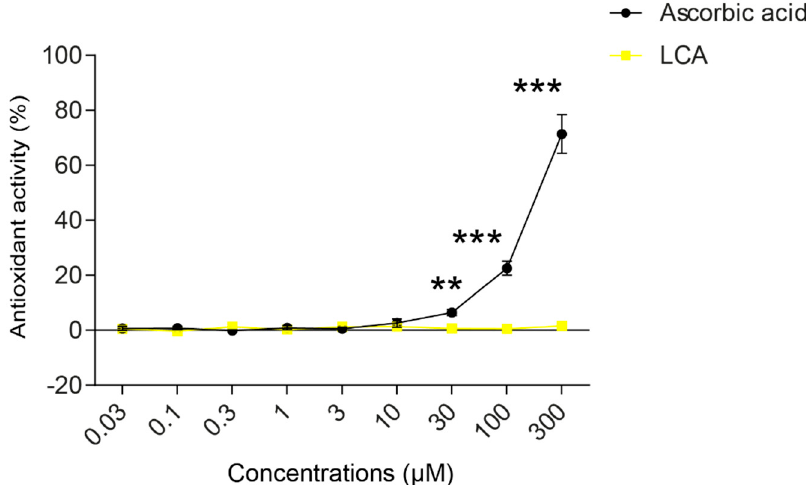
Figure 6. LCA did not act as an antioxidant. The ABTS radical scavenging assay was done in 96-well